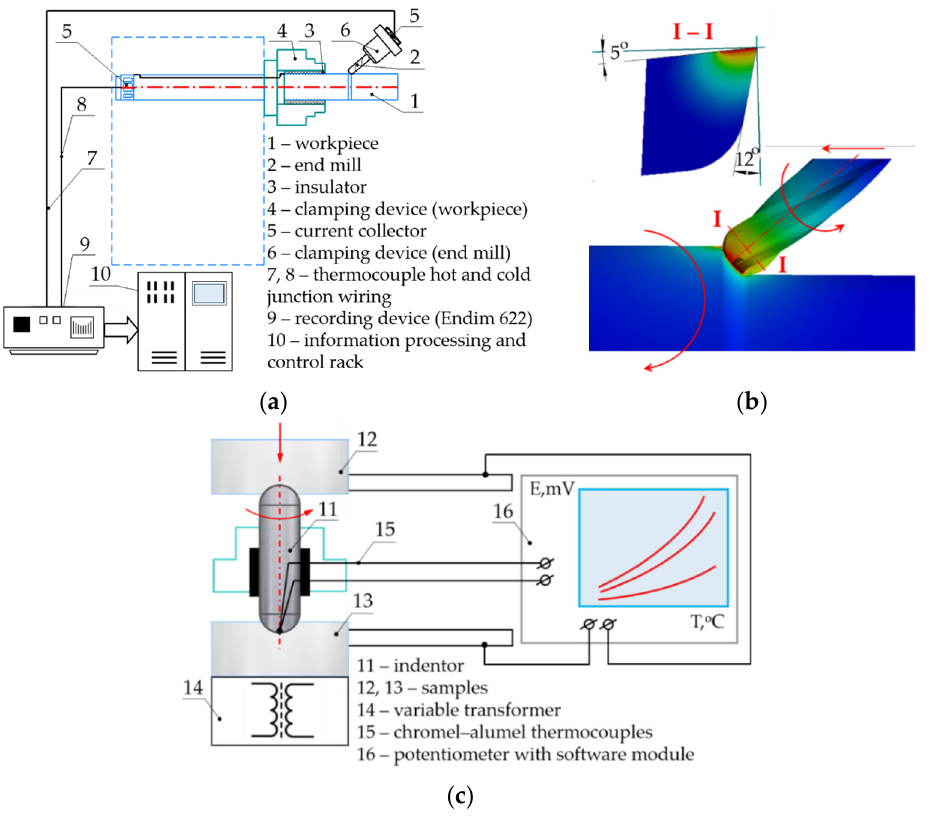
Figure 4. Functional diagram of a system based on a turning–milling machine for measuring the average cutting temperature ( a ); visualization of the temperature distribution at the cutting edge and adjacent layers of tool material ( b ); and calibration diagram of a natural thermocouple ( c